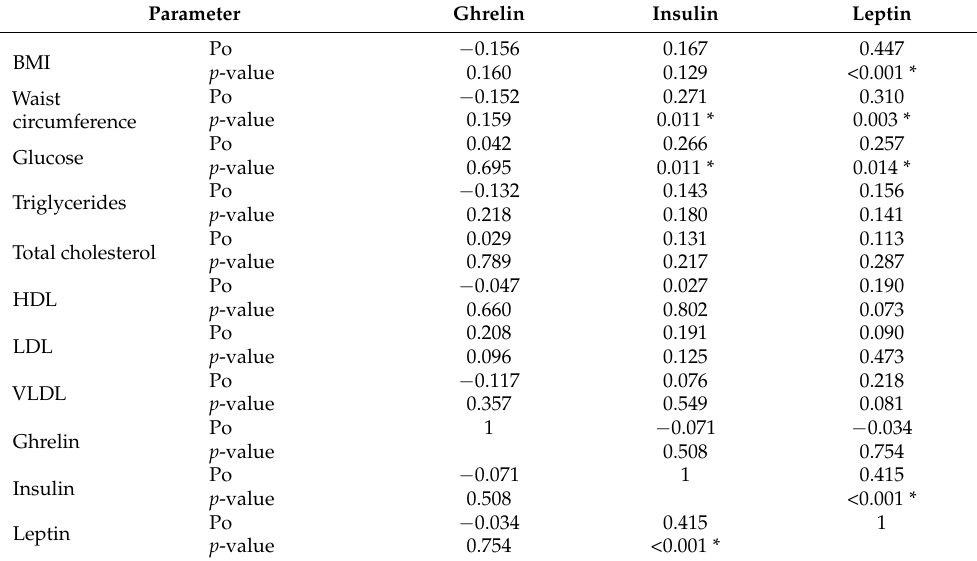
Table 5. Spearman’s correlation analysis between hormones, body mass index, and biochemical parameters of the lipid spectrum in patients with metabolic